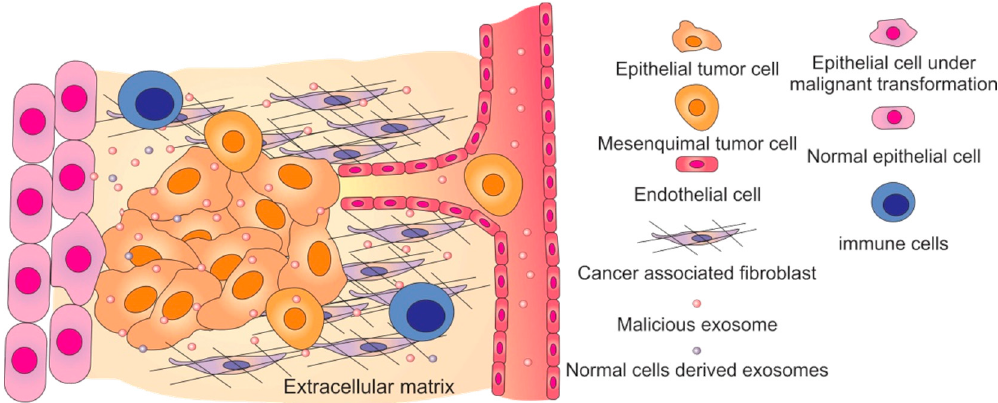
Figure 3. Modulation of the tumor microenvironment mediated by malicious exosomes. Malicious exosomes are involved in the maturation of the tumor microenvironment by inducing malignant transformation of normal epithelial cells, inducing the transformation of fibroblasts into cancer-associated fibroblasts, inhibiting the immune system, stimulating the angiogenic process, and inducing the epithelial to mesenchymal transition of epithelial tumor cells [1].